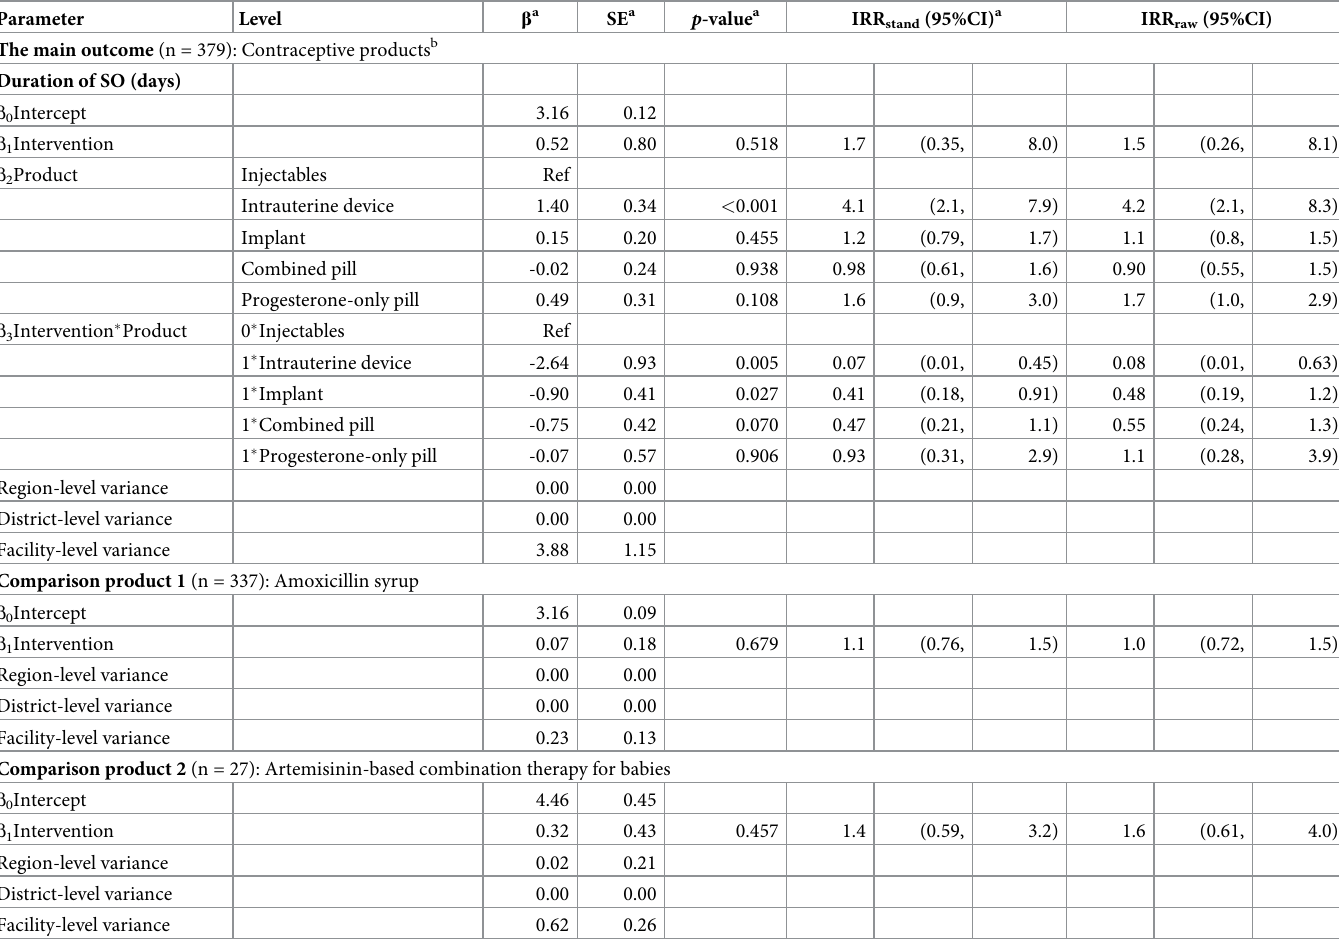
Table 2. Effect of the Informed Push Model intervention on stockout duration for contraceptive and comparison products in Senegalese health